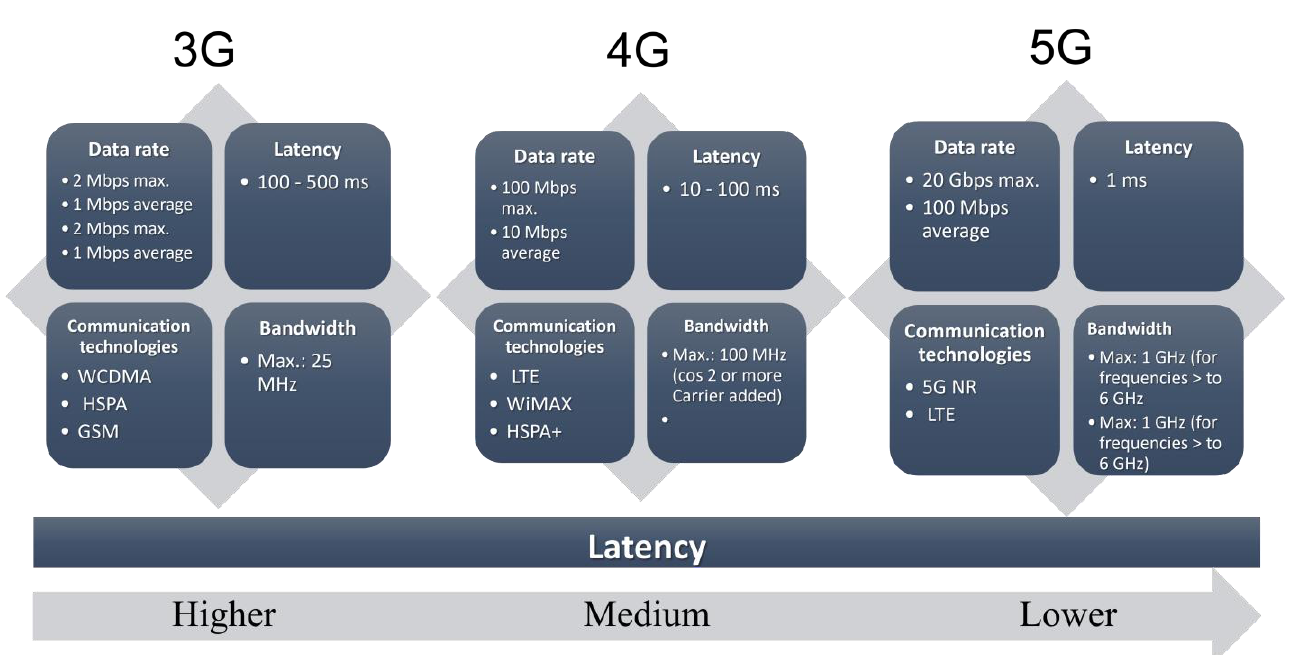
Figure 7. Comparison of network groups.